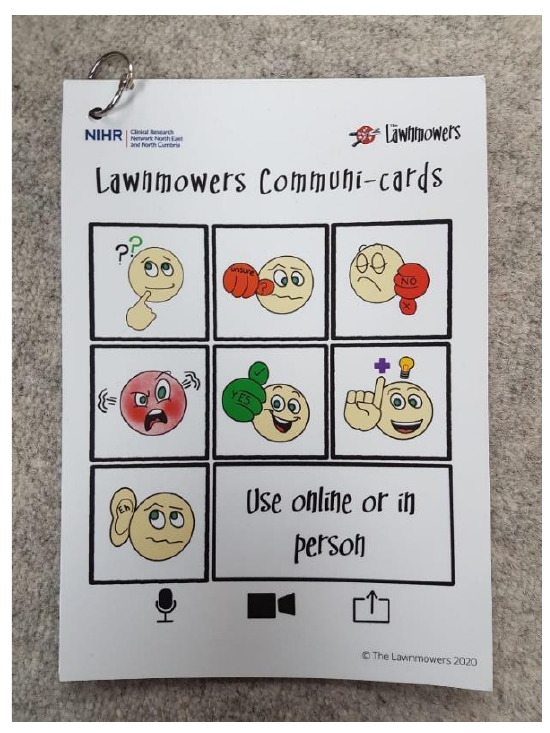
Figure 1. Communi-cards to support accessibility in verbal